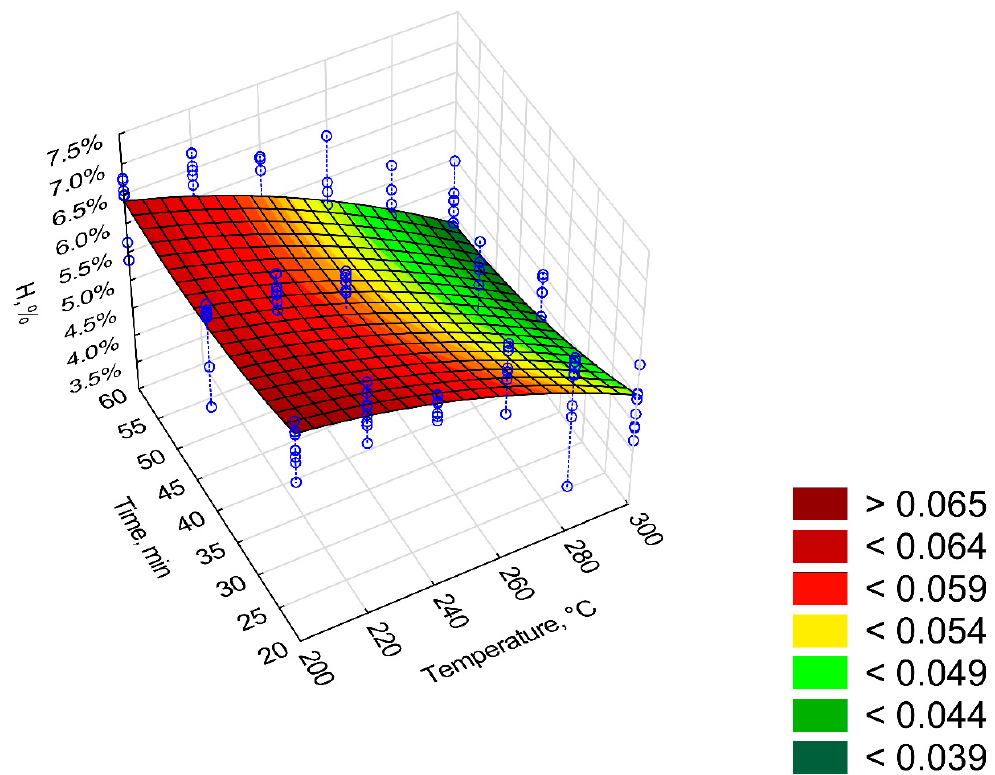
Figure 12. Visualization of 3D model of H content of torrefied pruned biomass. Table 10. Statistical evaluation of H content model of torrefied pruned biomass.